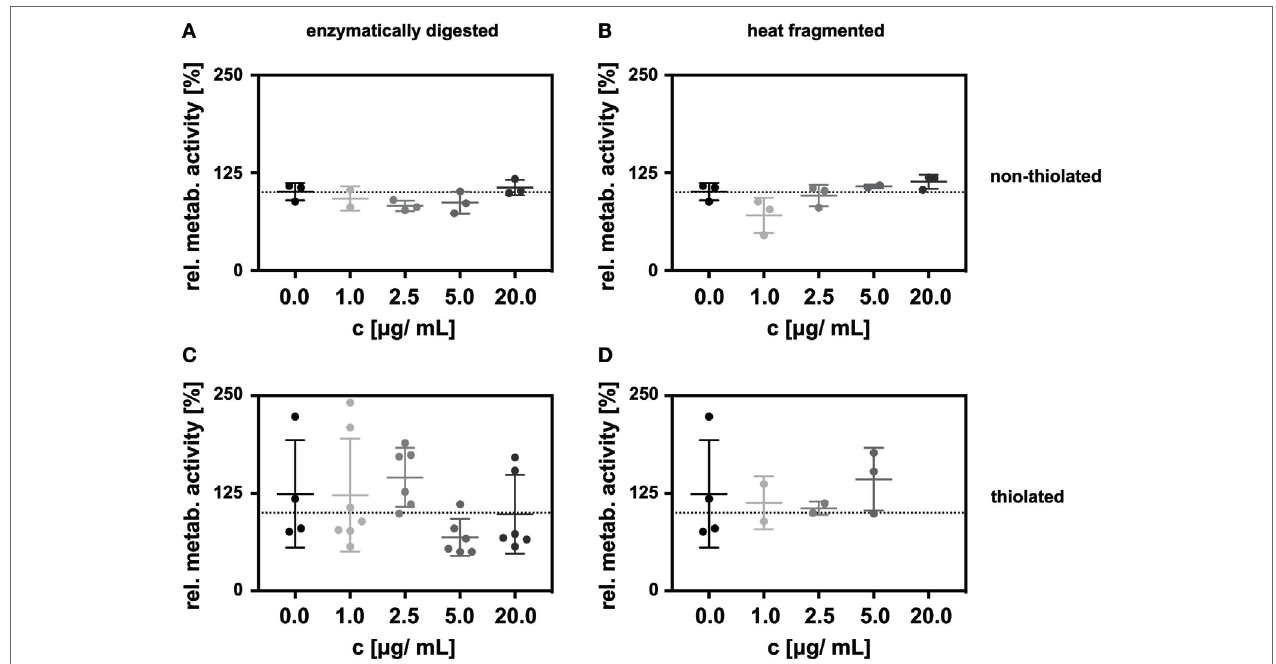
FigUre 2 | Incubation of lymphatic endothelial cells (LECs) with HA oligosaccharides (sHA) in solution had no impact on the relative metabolic activity of the cells. The graphs show the metabolic activity of LECs normalized to the amount of DNA on c(RGDfE) functionalized click-PEG surfaces after exposure to (a) enzymatically digested sHA and (B) heat-fragmented sHA and their respective thiolated species (c,D) . The Kruskal–Wallis test followed by the Dunn’s multiple comparison indicated no significant difference between the control and the different concentrations of the hyaluronan species.